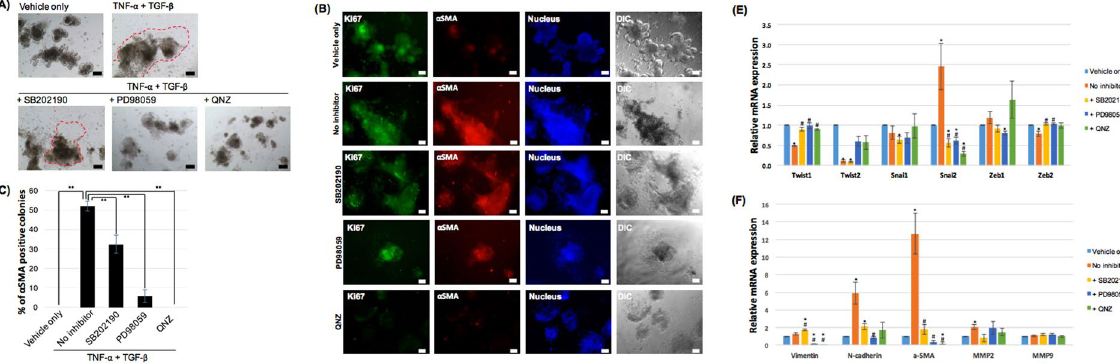
Figure 6. TNF- α promotes mesenchymal phenotypic changes in TGF- β 1 treated IEOs by regulating gene expression associated with EMT. ( A ) Representative images of the IEOs following TNF- α , TGF- β treatment with or without inhibitors. Bars, 100 μ m. ( B ) The percentage of α -SMA positive colonies was determined. Data were presented as the mean ± SEM; n = 4 samples per bar, ** p < 0.01. ( C ) The expression of α -SMA and Ki67 was examined in TGF- β 1 treated IEOs with or without inhibitors. Bars, 50 μ m. ( D ) Relative mRNA expression for EMT-related transcription factors was quantified after TNF- α treatment in IEOs. ( E ) Relative mRNA expression for EMT effector genes was quantified after TNF- α treatment in IEOs. Data are presented as the mean ± SEM; n = 3 samples per bar, * p < 0.05, control versus TNF- α or inhibitors; # p < 0.05, TNF- α versus